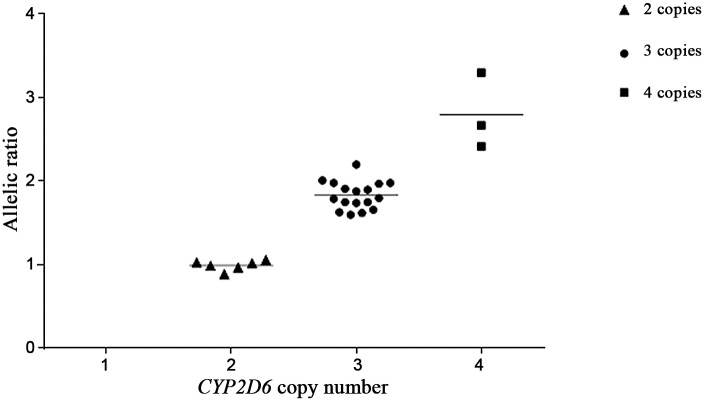
Scatter plot showing the mean allelic ratios for samples with 2, 3, and 4 CYP2D6 gene copy numbers.